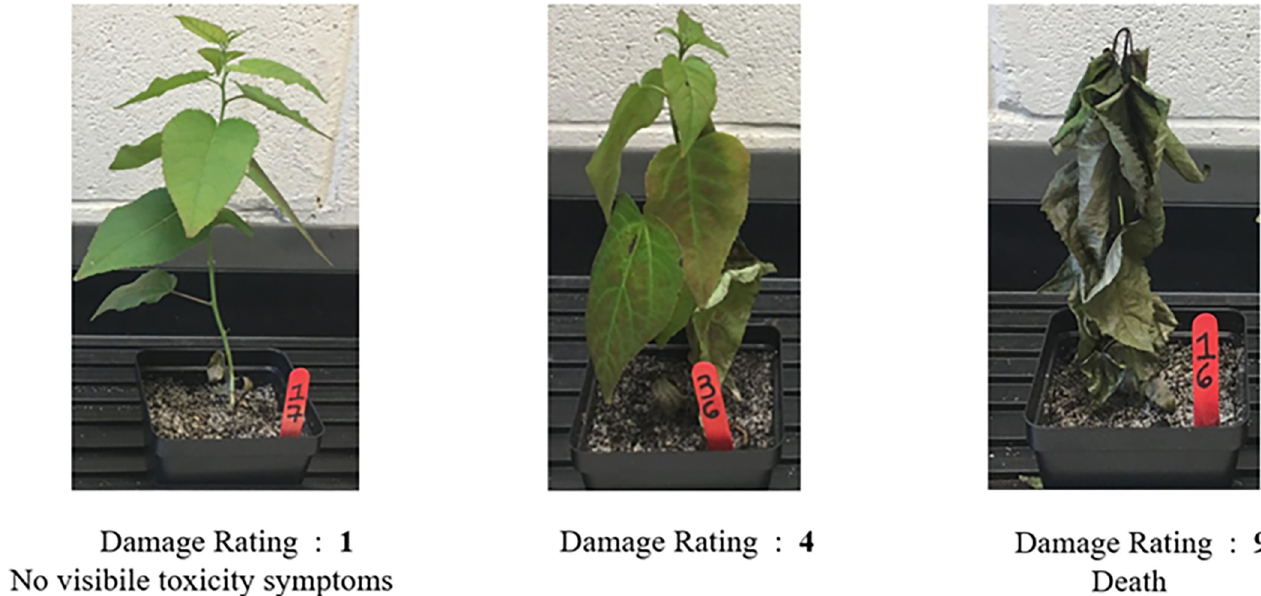
Fig 1. A nickel-resistant (left), moderately nickel-resistant (middle) and nickel-susceptible (right) P . tremuloides seedling on day seven (7) after treatment with 1,600 mg/kg nickel nitrate.